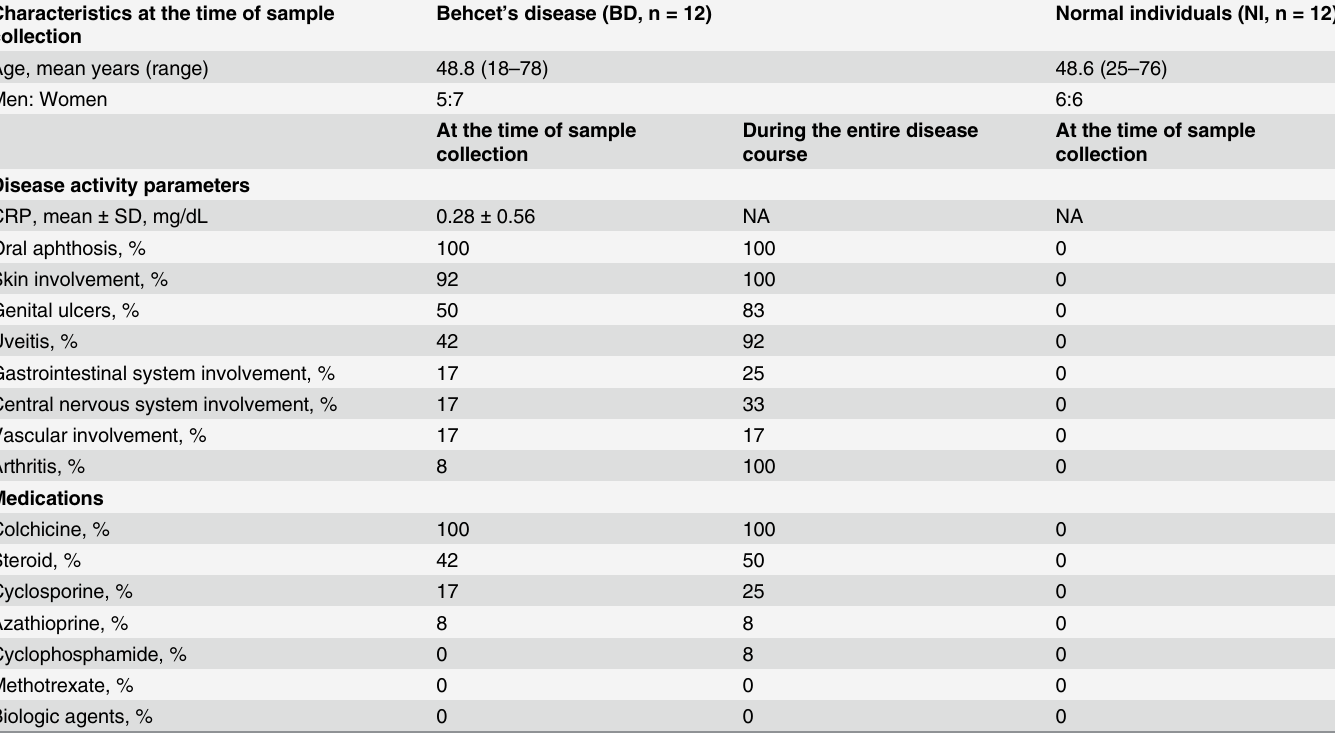
Table 1. Demographical and clinical characteristics of patients with Behcet ’ s disease and normal